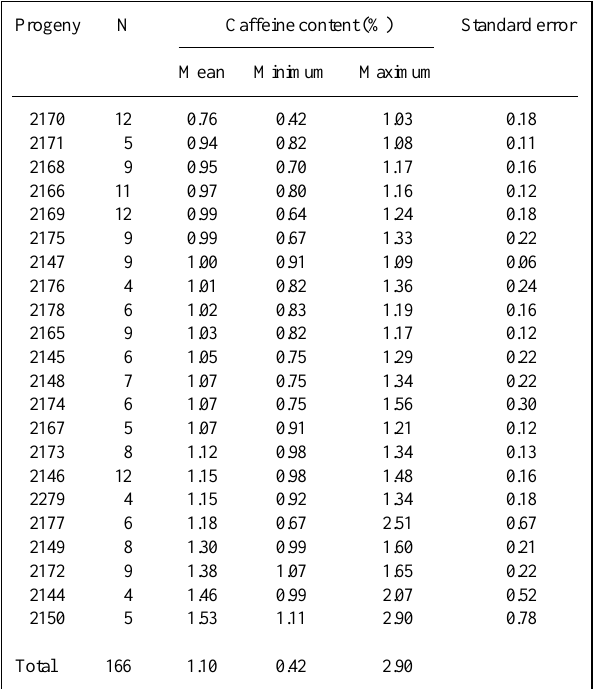
Table II - Caffeine content (%) of beans from 22 Coffea arabica progenies from the Illubabor region of Ethiopia. Progeny